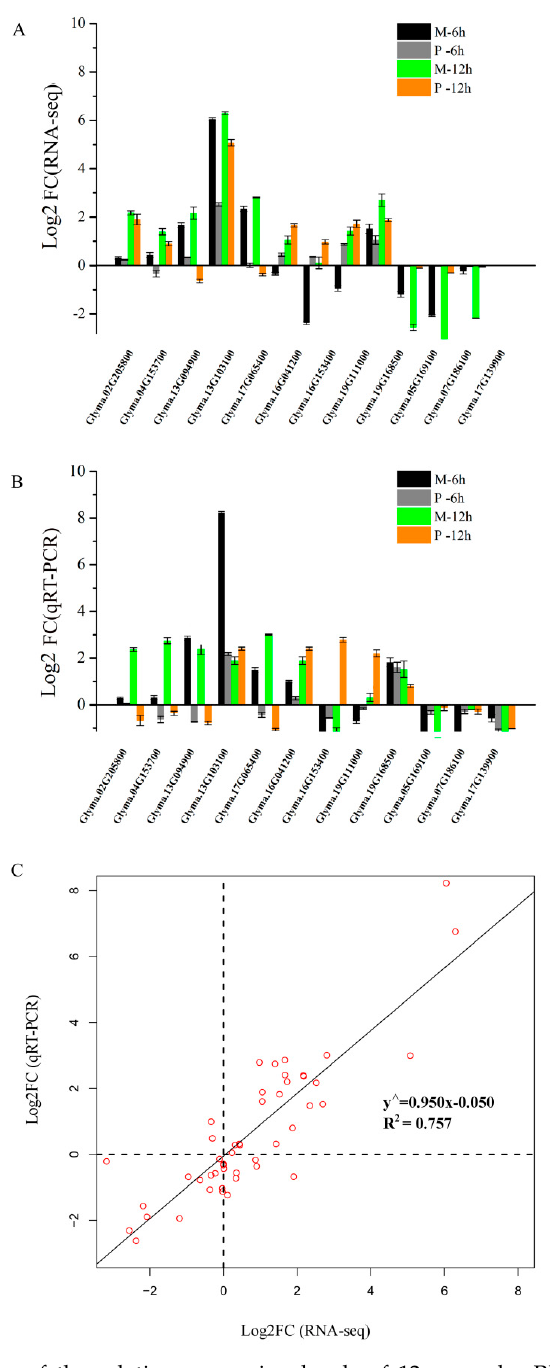
Figure 7. Comparison of the relative expression levels of 12 genes by RNA-seq and qRT-PCR analysis. ( A ) Relative expression of 12 genes at 6 and 12 h after 25 µ M AlCl 3 (pH 4.3) stress compared with control (0 µ M AlCl 3 , pH 4.3) by RNA-seq. ( B ) Relative expression of 12 genes at 6 and 12 h after 25 µ M AlCl 3 (pH 4.3) stress compared with control (0 µ M AlCl 3 , pH 4.3) by qRT-PCR. ( C ) The correlation analysis between qRT-PCR and RNA-seq using Log 2 FC. FC represents fold change. Glyma.02G205800 and Glyma.04G153700 encode cellulose synthases; Glyma.13G094900 , Glyma.13G103100 and Glyma.17G065400 encode xyloglucan endo-transglycosylases (XET); Glyma.16G041200 , and Glyma.19G111000 encode glutamate dehydrogenases; Glyma.19G168500 encodes an auxin-induced protein (AUX / IAA family); Glyma.05G169100 belongs to the cupin family with nutrient reservoir activity; Glyma.07G186100 encodes a branched chain aminotransferase; Glyma.17G139900 encodes a seed storage